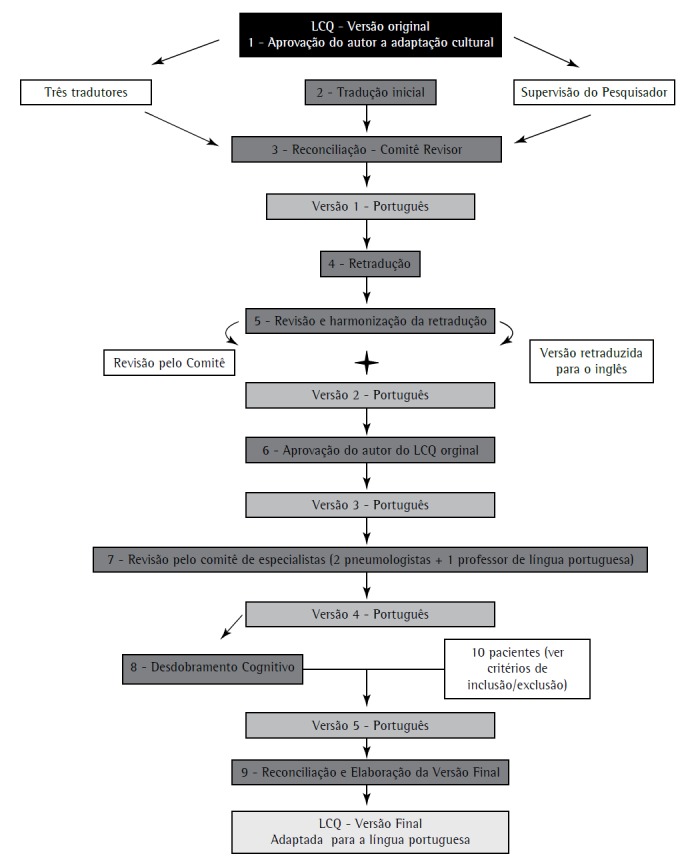
 Súmula do processo de adaptação transcultural do Leicester Cough
Questionnaire (LCQ) para a língua portuguesa falada no Brasil.